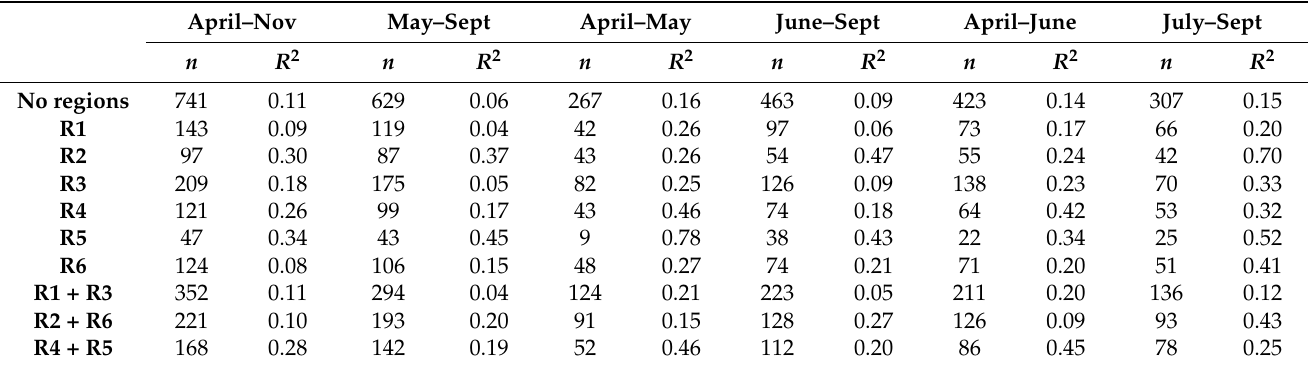
Table 9. The number of match-ups ( n ) and the determination coefficients ( R 2 ) of the quadratic polynomial regression model for the best algorithm out of 25,013 for different regions (R1–R6) or region combinations for deriving total phosphorus (TP).